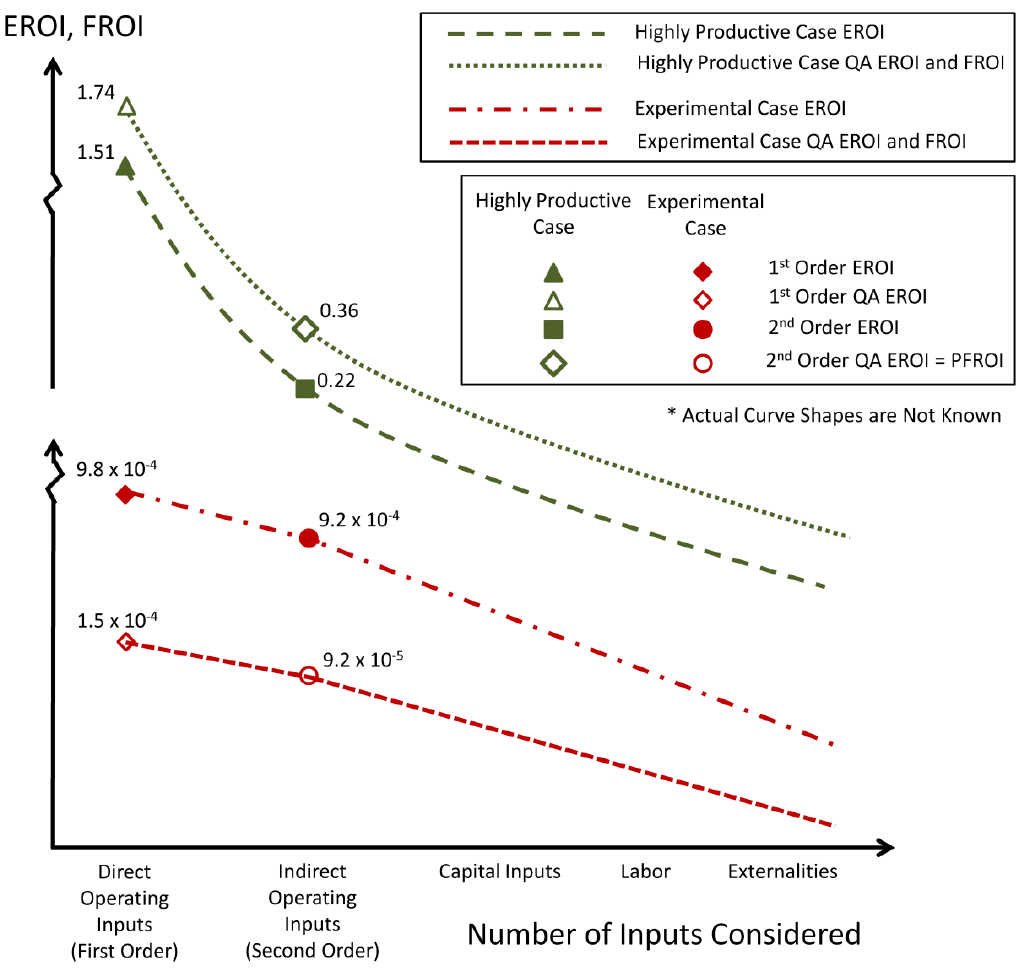
Figure 2. The EROI and PFROI for the Experimental Case and the Highly Productive Case decline as more inputs are considered. The curves are presented for illustration only, as the curve shapes are